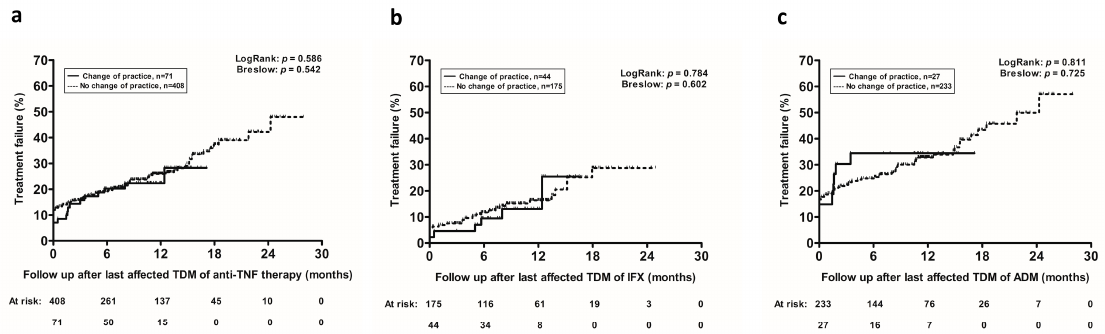
Figure 1. Kaplan–Meier cumulative probability curves of treatment failure in patients treated with ( a ) anti-TNF therapy with no treatment changes (dotted line) or a retrospectively (theoretically) different therapeutic decision (solid line) following correction of originally reported results, stratified also by anti-TNF therapy type, ( b ) infliximab, or ( c ) adalimumab. Abbreviations: IFX: infliximab; ADM: adalimumab; TDM: therapeutic drug monitoring; anti-TNF: anti-tumor necrosis factor. After adjusting for potential confounding factors, a retrospective (theoretical) treatment change was not associated with treatment failure (hazard ratio (HR): 1.452; 95%CI: 0.805–2.618; p = 0.216), which was consistent for both infliximab- (HR: 1.977; 95%CI: 0.695–5.627; p = 0.201) and adalimumab-treated patients (HR: 1.484; 95%CI: 0.721–3.054; p =